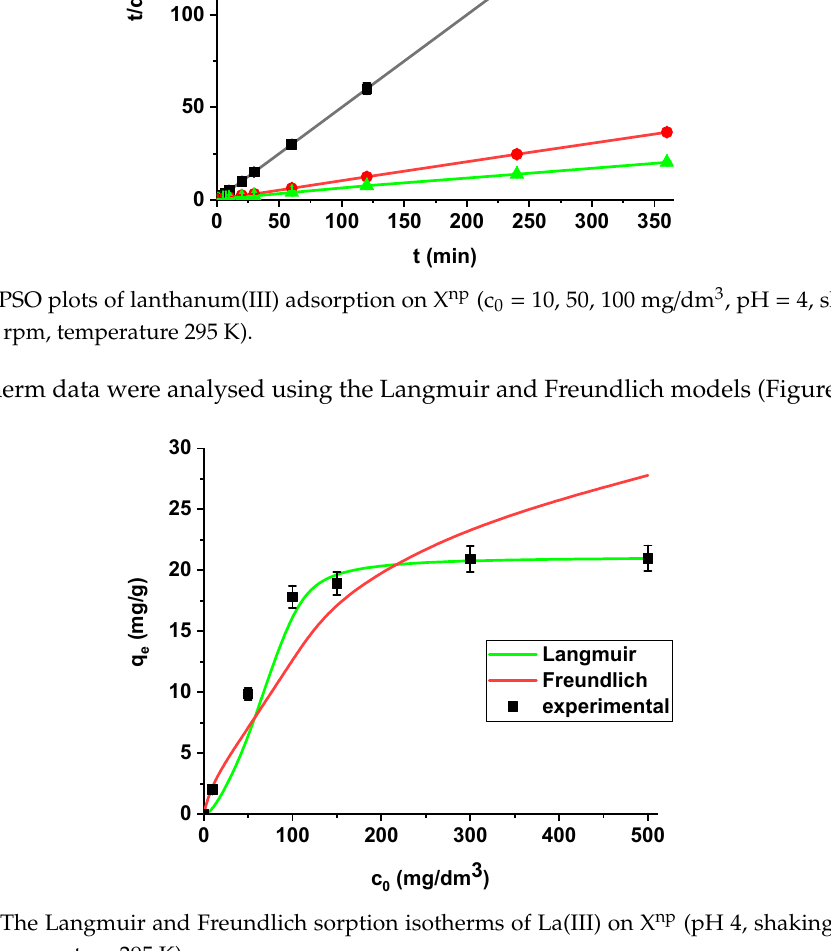
Figure 9. The Langmuir and Freundlich sorption isotherms of La(III) on X np (pH 4, shaking speed 180 rpm, temperature 295 K). 180 rpm, temperature 295